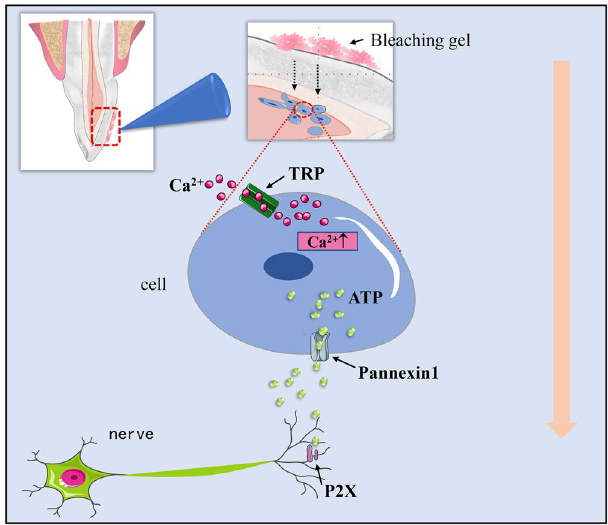
Figure 6. Schematic diagram presenting the hypothesis on the role of TRPA1 in bleaching sensitivity. Tooth bleaching leads to the activation of TRPA1, which promotes the intracellular absorption of calcium. In turn, PANX1 is activated, which induces the secretion of ATP that acts as a neurotransmitter and induces